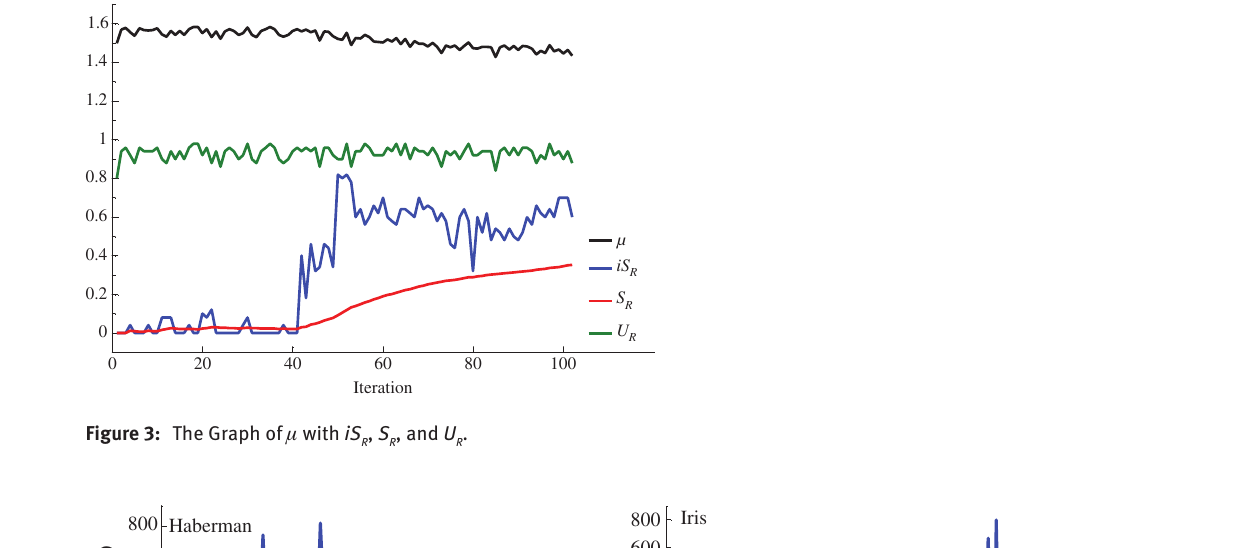
Figure 3: The Graph of μ with iS